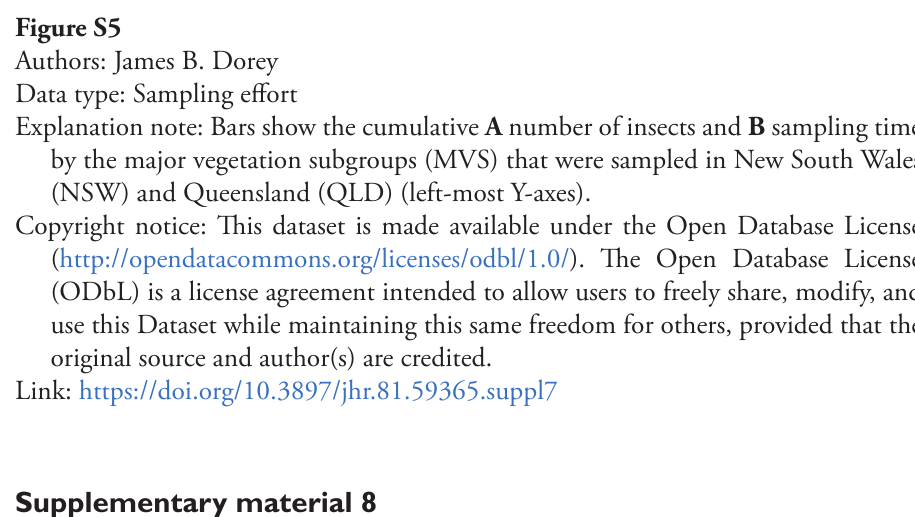
Data type: Wildfire data for Australian